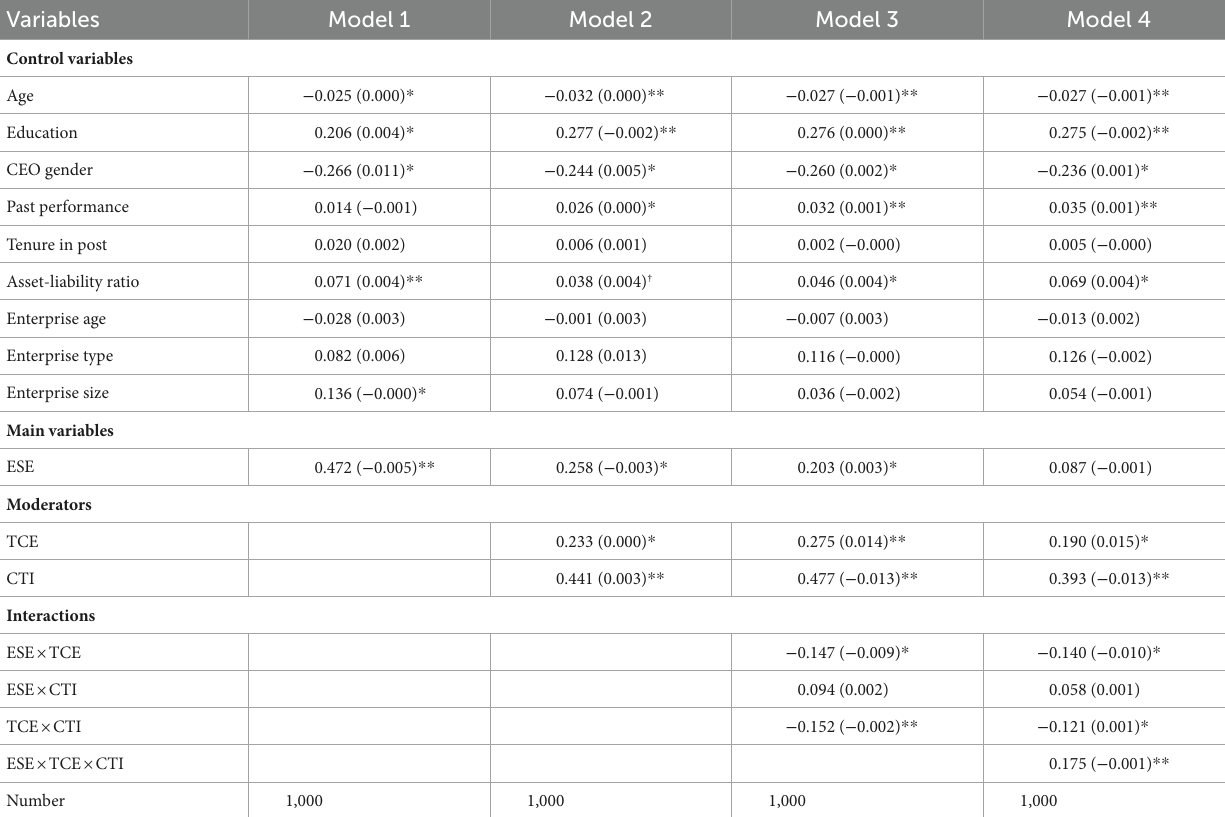
TABLE 5 Robustness test, bootstrap test bias, and